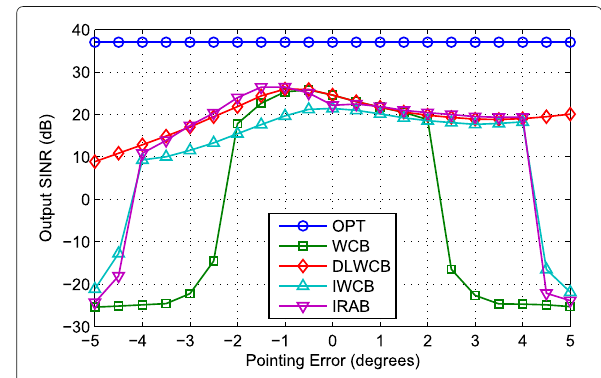
Fig. 7 Output SINR versus input SNR Fig. 9 Output SINR versus pointing